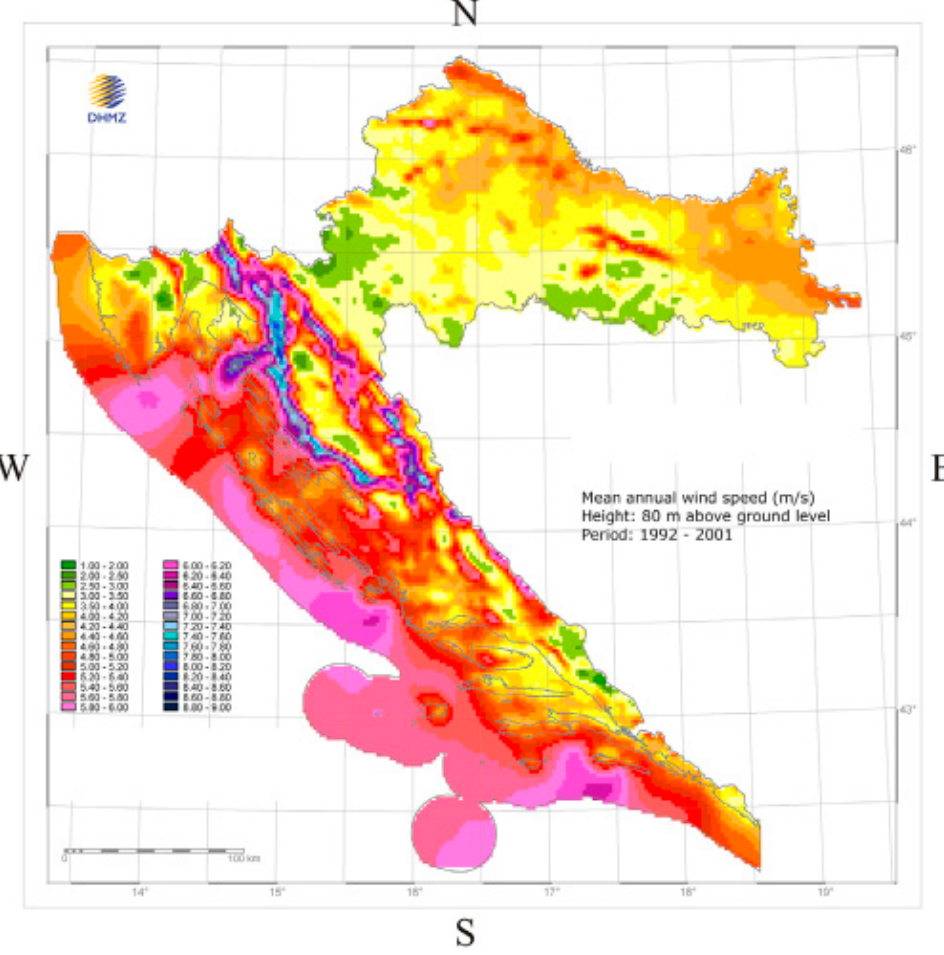
Figure 3. The average wind speed at 80 m height [40].